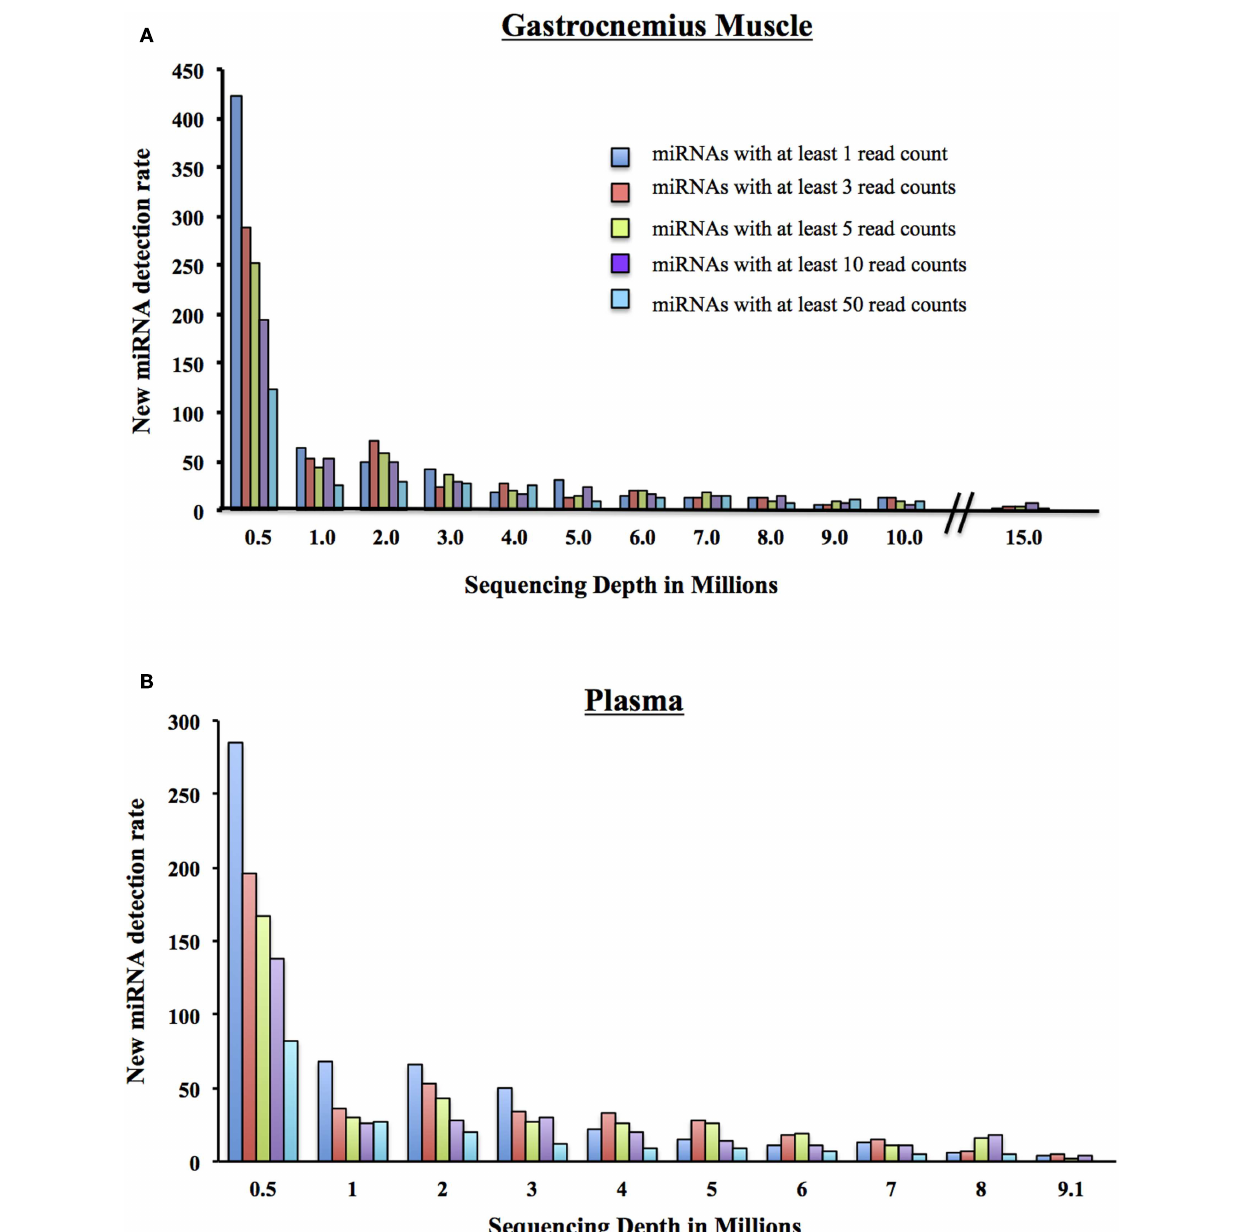
(B) As a million reads at a time are added to the sequencing depth of the Plasma, the number of newly detectable miRNAs is reduced. Displayed are the number of newly detected miRNAs with at least 1, 3, 5, 10, or 50